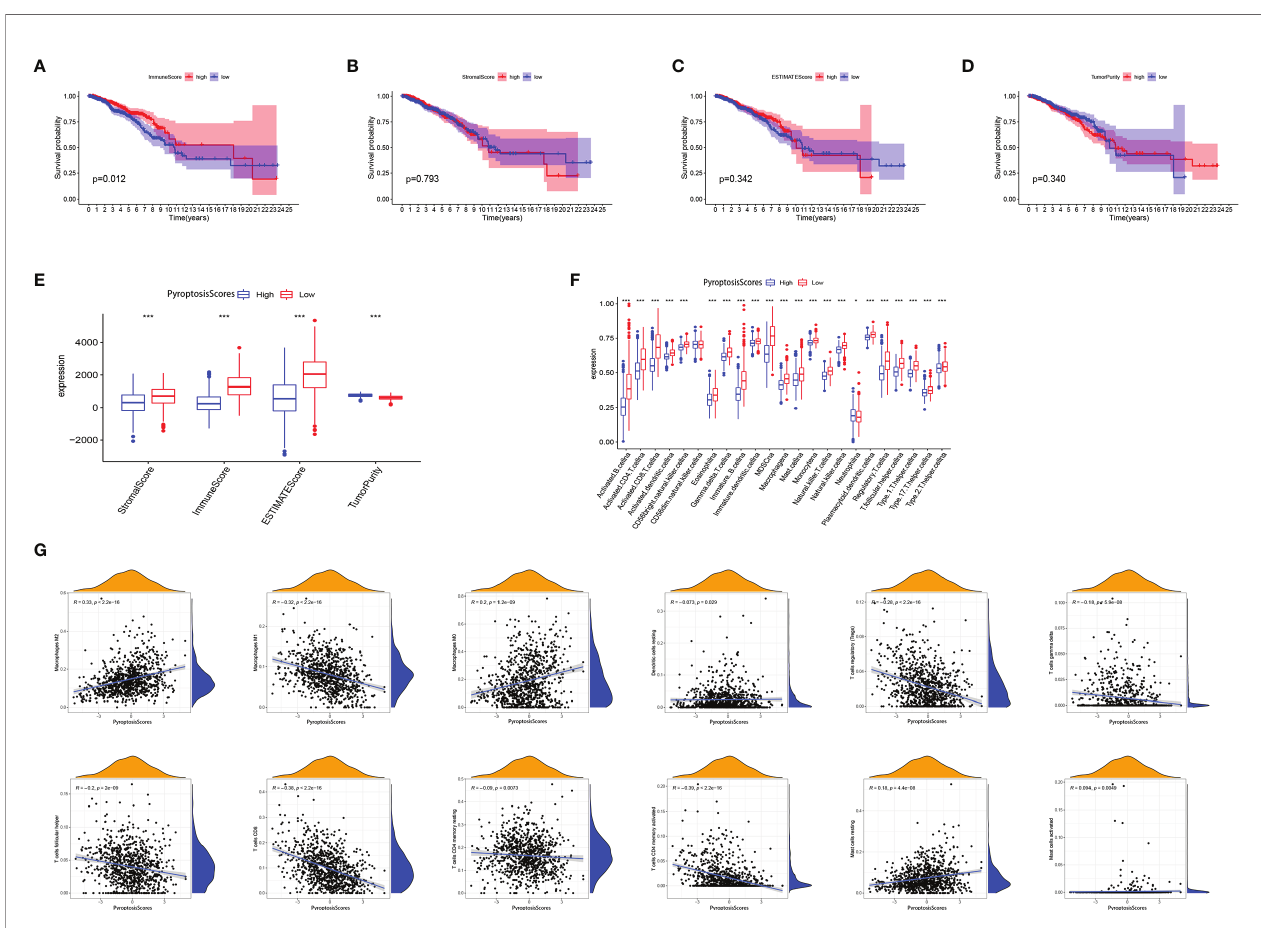
FIGURE 8 | The role of PyroptosisScore in the tumor microenvironment. Survival analysis of ImmuneScore (A) , StromalScore (B) , ESTIMATEScore (C) , and TumorPurity (D) in BRCA patients. (E) The level of ImmuneScore, StromalScore, ESTIMATEScore, and TumorPurity was signi fi cantly different in the high and low PyroptosisScore subgroups. (F) The abundance of each TME-in fi ltrating cell in high and low PyroptosisScore subgroups. (G) Correlation analysis between PyroptosisScore and immune in fi ltrating cells. * P < 0.05, ** P < 0.01, *** P <